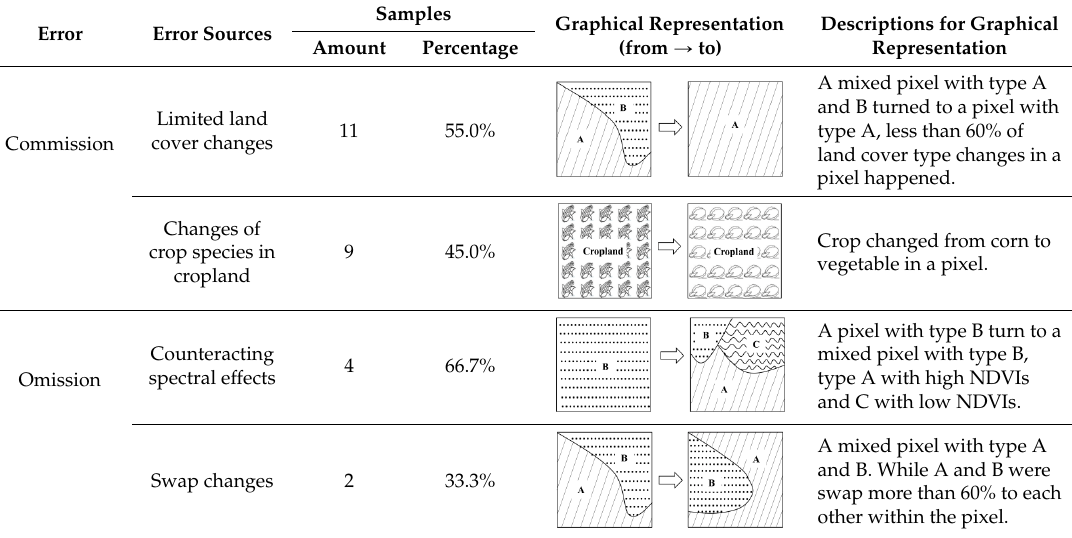
Table 6. Commission error sources and graphical representation of changes.